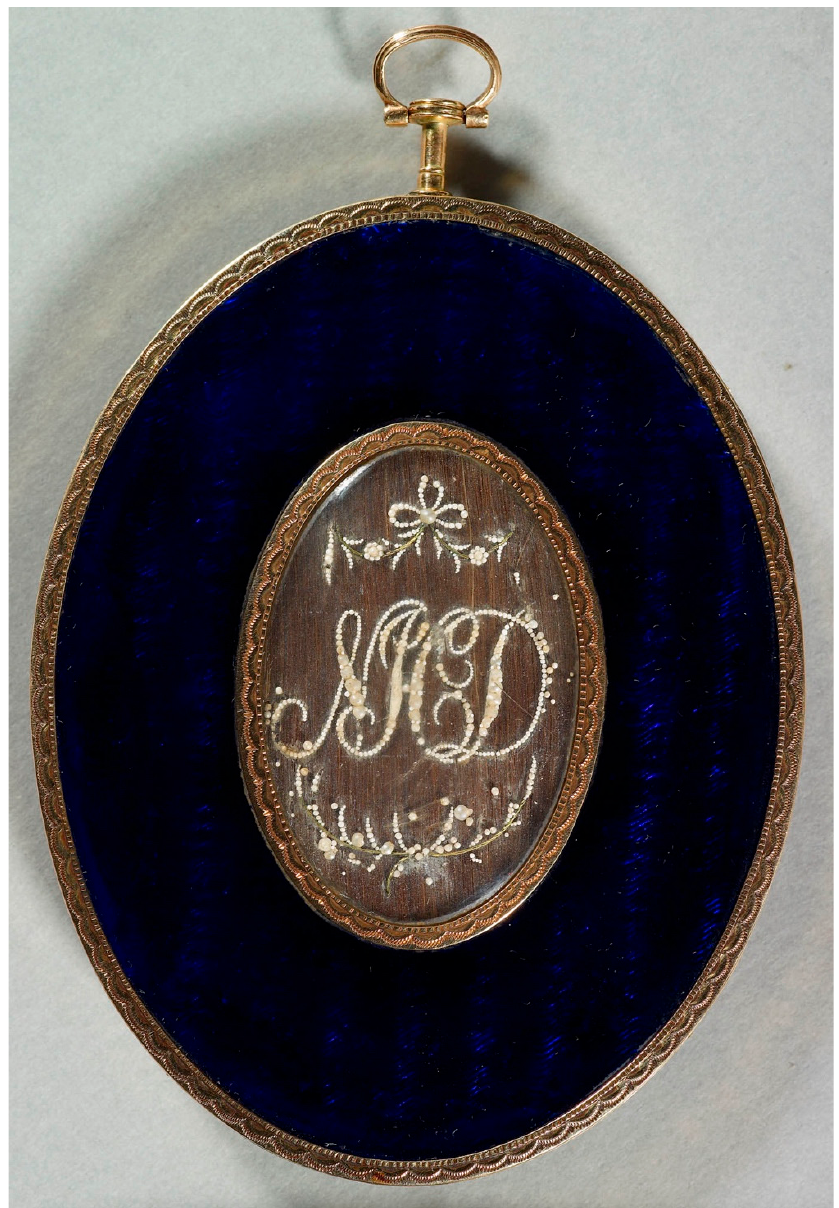
Figure 5. Portrait of a Gentleman (Portrait a Man formerly called Sir Nathaniel Dance Holland (1734–1811). Reverse with monogram “NHD”, c. 1790, watercolor on ivory laid on card, 90 × 70 mm. The Royal Collection Trust, London. Credit line: Digitized by The Royal Collection Trust, London.